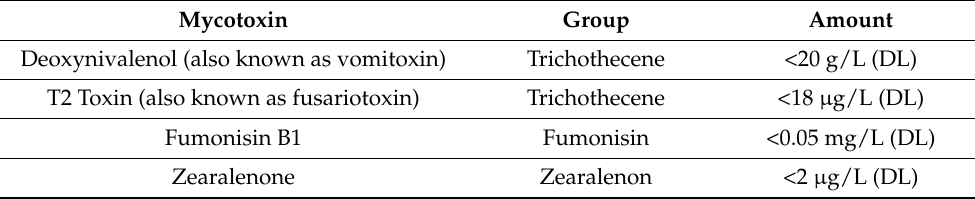
Figure 10. Micromorphology of Fusarium tonkinense (differential interference contrast microscopy). ( a ) Mycelial strand with conidiohores. ( b ) Curved microconidia. Scale bars = 20 µm. Table 2. Mycotoxin production (DL: Detection